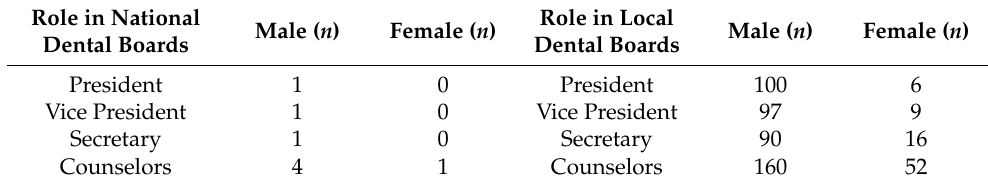
Table 1. Roles in nationals and local dental boards.